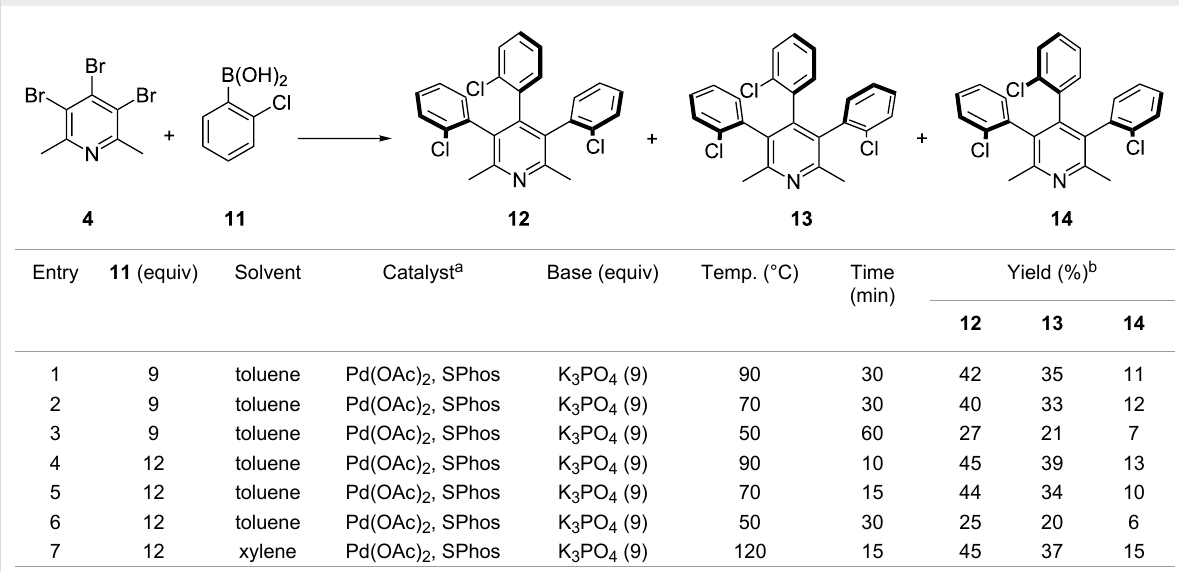
Table 4: Optimization of the reaction conditions for the synthesis of 12 – 14